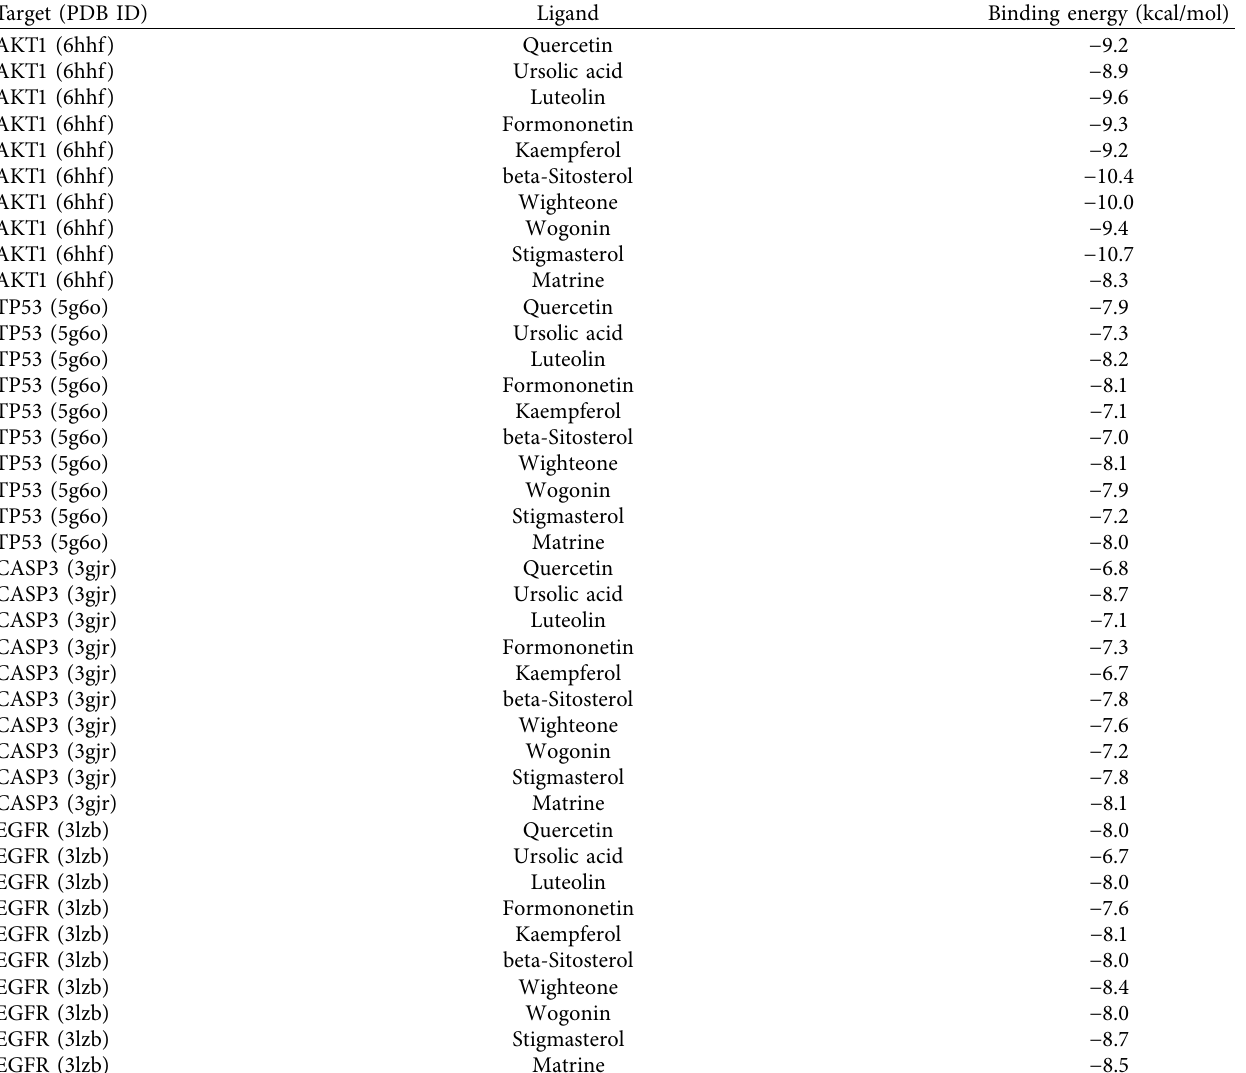
Table 3: Te molecular docking results of 4 key targets with 10 potential